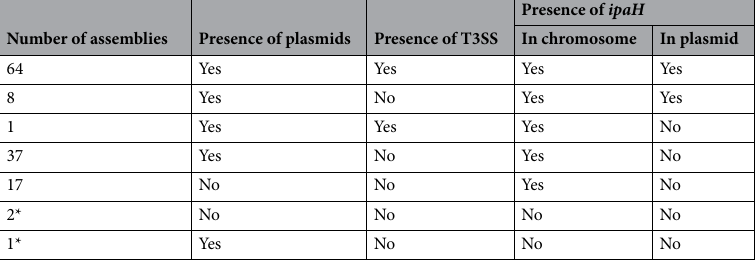
1 − identity (cid:30) (cid:29)